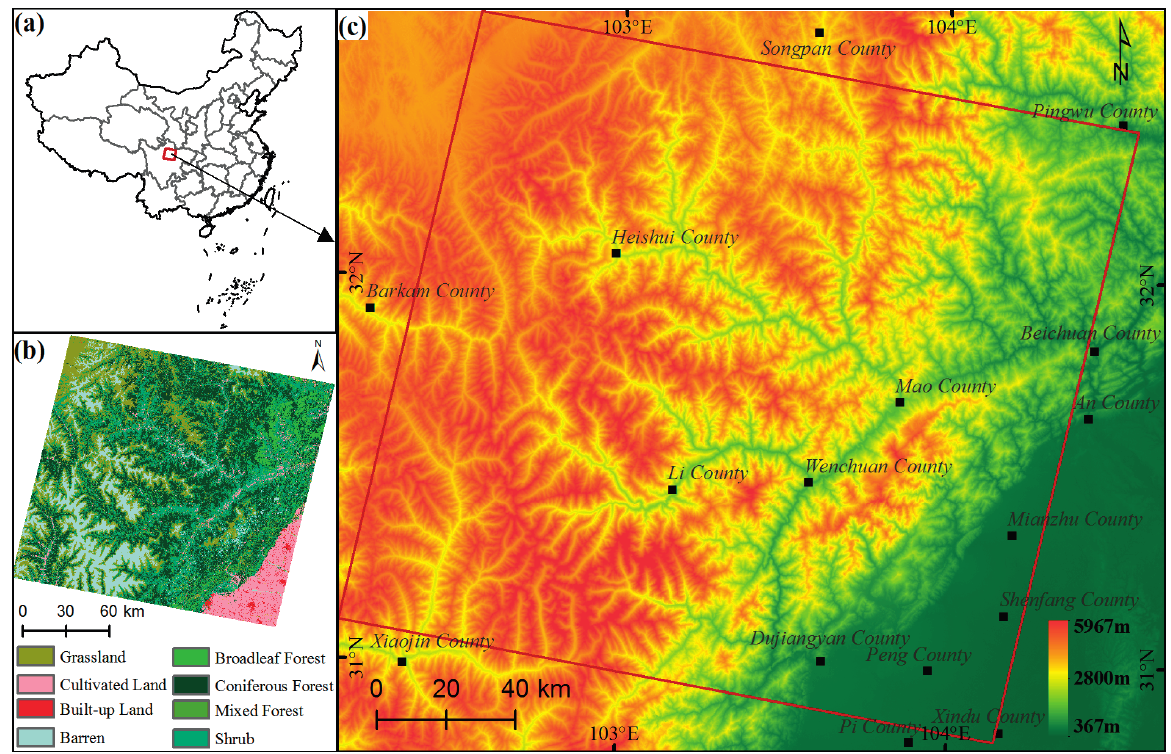
Figure 1. ( a ) Location of study area in China. ( b ) Land cover types in study area. ( c ) DEM of study